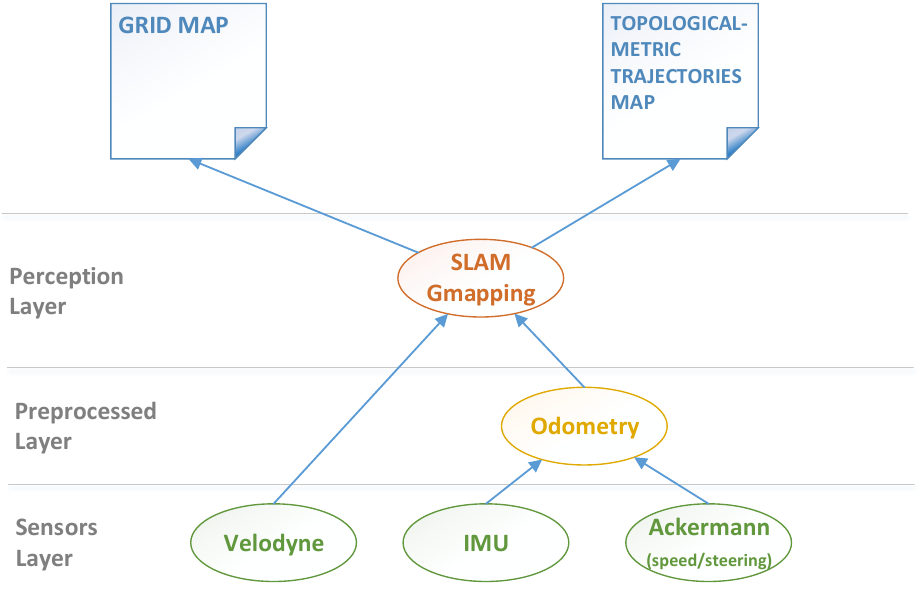
Figure 2. Robot operating system (ROS) nodes scheme that shows the system architecture in the pre-execution phase for our first framework implementation. Notice that each node is placed at its corresponding abstraction level. In this phase we record data from the sensors layer and process them offline using the architecture shown to obtain the grid map and trajectories that will be used in the execution